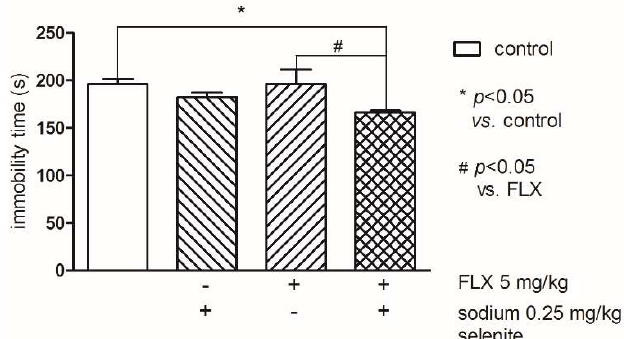
Figure 3. The effects of combined administration of Se and fluoxetine (FLX) on the total duration of immobility in the FST in mice. The values represent the mean ± SEM. Sodium selenite was injected IP 30 min before the test. * p < 0.05 vs. control vehicle-treated group, # p < 0.05 vs. FLX (Bonferroni’s test).